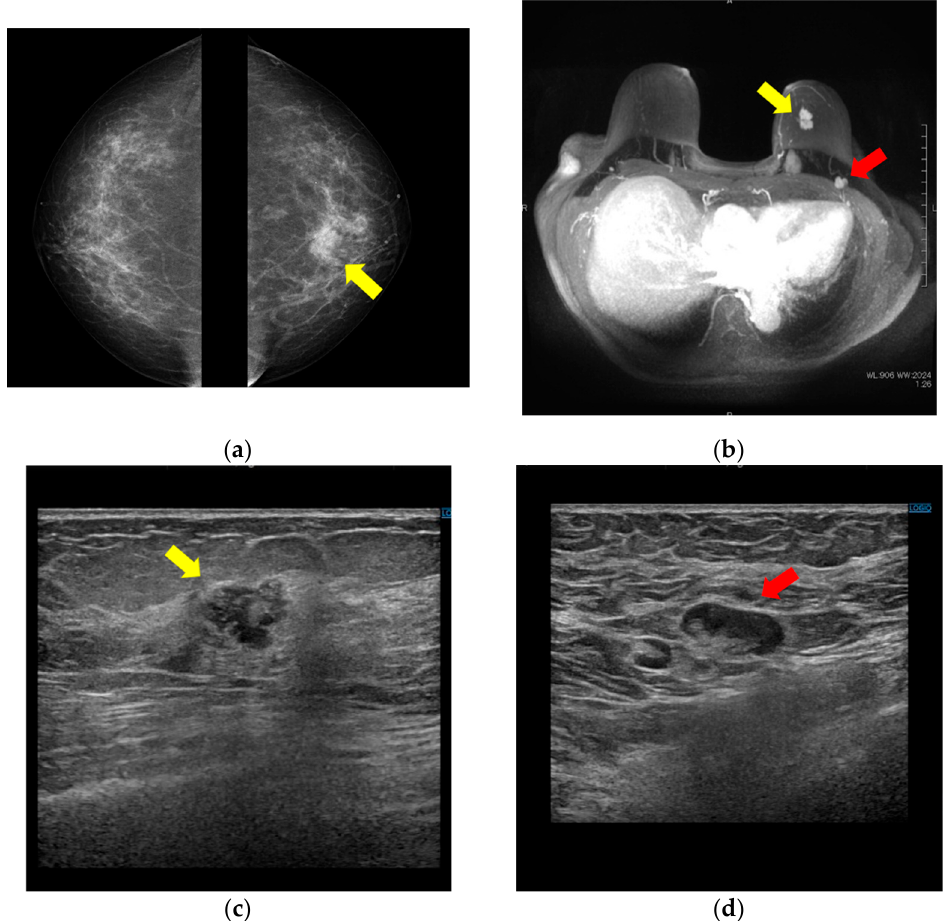
Figure 1. Breast mass and axillary lymph node on mammography, MRI, and ultrasound. ( a ) Bilateral mediolateral oblique mammogram demonstrates a 20 mm irregular mass with indistinct margin in the upper area (yellow arrow). ( b ) MRI shows a 29 mm irregular mass that showed contrast enhancement with fast-washout pattern in the upper area of the left breast (yellow arrow) and enlarged lymph nodes in the left axilla (red arrow). ( c ) Ultrasonography reveals a 17 mm irregular hypoechoic tumor in the upper area of the left breast (yellow arrow) and ( d ) enlarged lymph nodes with thickened cortex in the left axilla (red arrow).